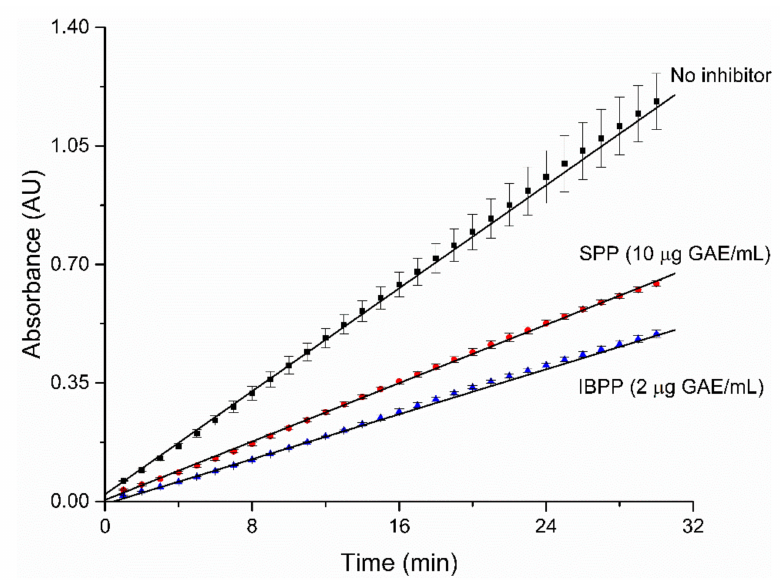
Figure 2. Reaction progress curve in the absence of inhibitors, and in the presence of SPP or IBPP as an